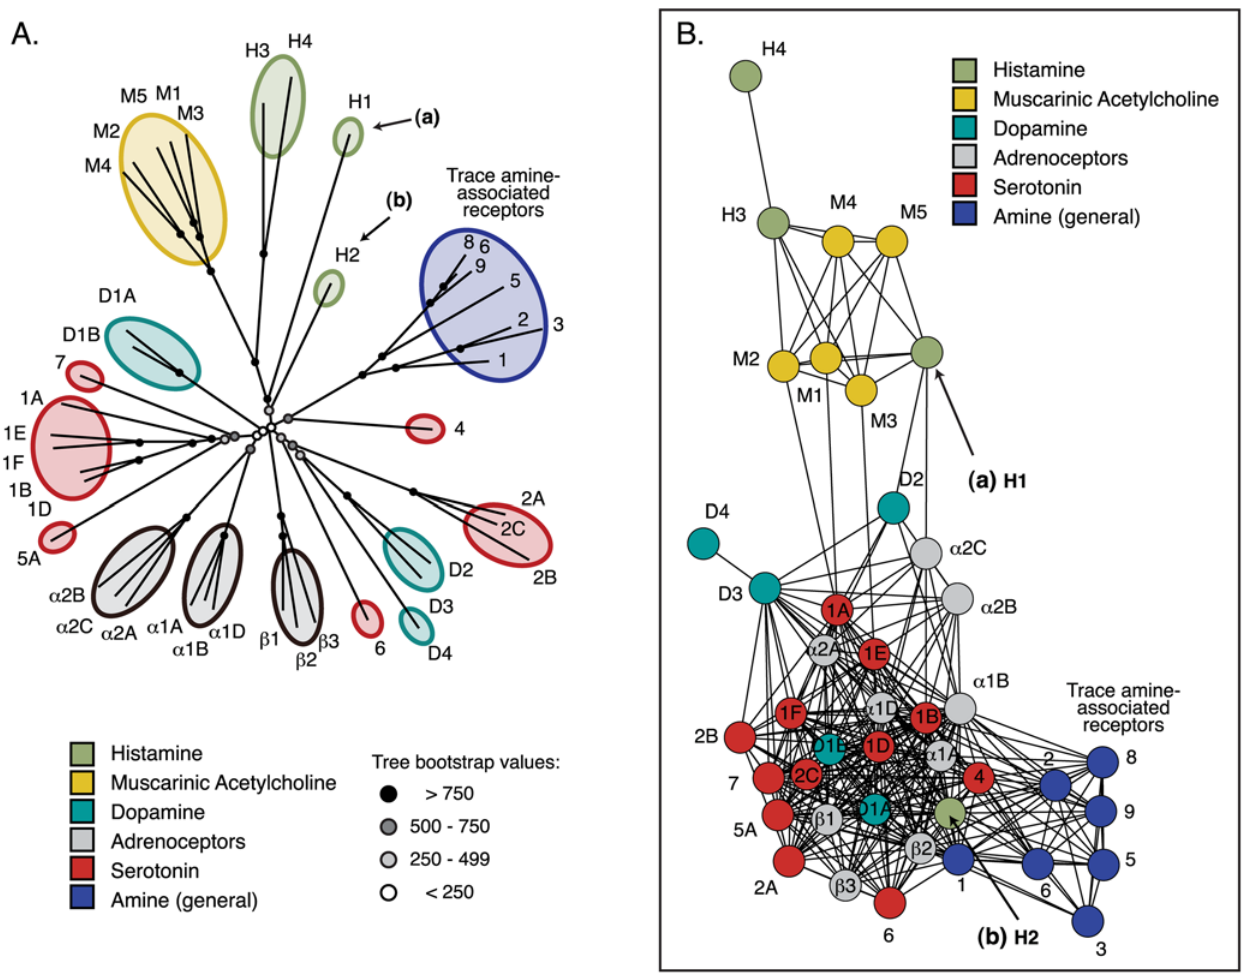
Figure 2. Comparison of trees and networks: amine-binding GPCRs. A. Neighbor-Joining tree describing the interrelationships of 42 amine- binding human GPCR domains. Sequences are labeled according to the common name for their class (e.g., the sequence labeled a 1D is adrenoceptor a 1D; see additional data file 5 for all sequence database identifiers). B. Sequence similarity network including the same 42 sequences as in (A). This network was thresholded at a BLAST E-value of 1 6 10 2 33 : only edges associated with E-values more significant than 1 6 10 2 33 are included in the network. This network contains 324 edges; the worst edges displayed correspond to a median of 30% identity over an alignment length of 280 amino acids. See Table I for a quantitative comparison of the two representations. The sequences labeled (a) and (b) are discussed in the